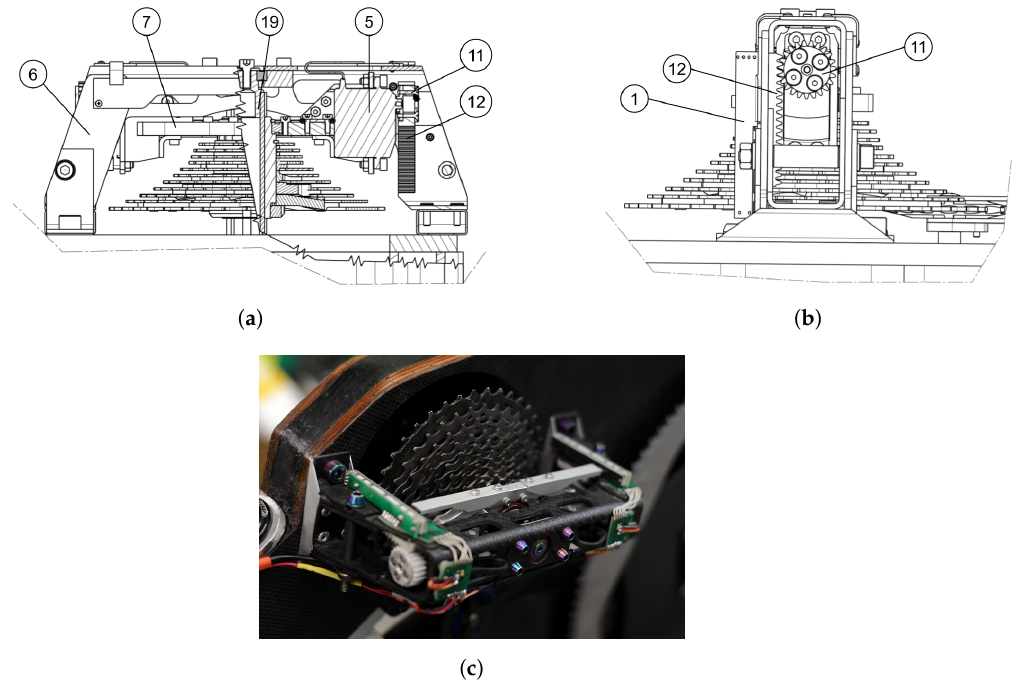
Figure 6. Second version of the moving cassette: ( a ) sectioned top view; ( b ) lateral view; and ( c ) assembled prototype.